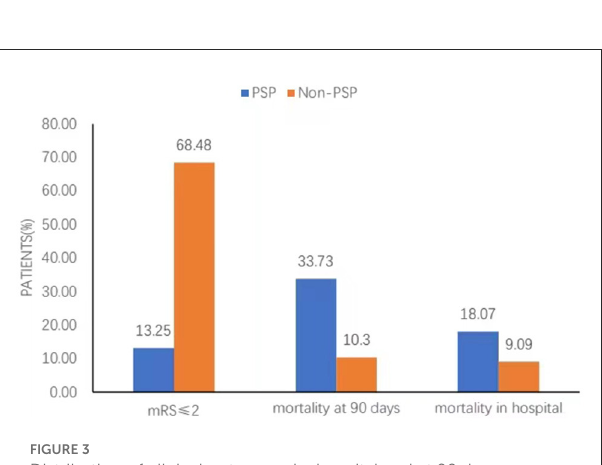
FIGURE3 Distribution of clinical outcomes in-hospital and at 90